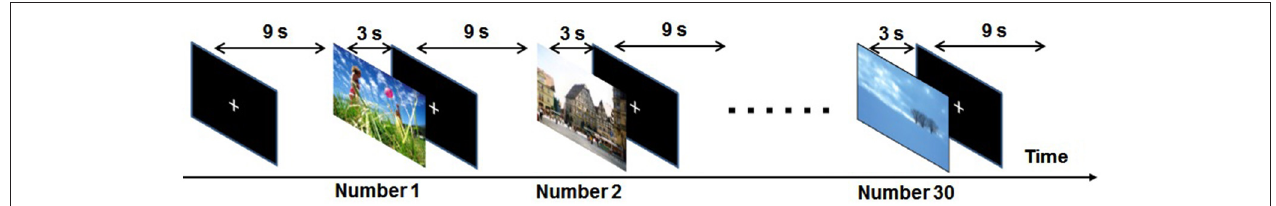
FIGURE 1 | Schematic diagram of the experimental paradigm in one run . During each run 30 picture stimuli (10 unpleasant, 10 neutral and 10 pleasant) were randomly presented for 3.0 s and each was followed by a 9.0-s white cross-hair in the middle of the